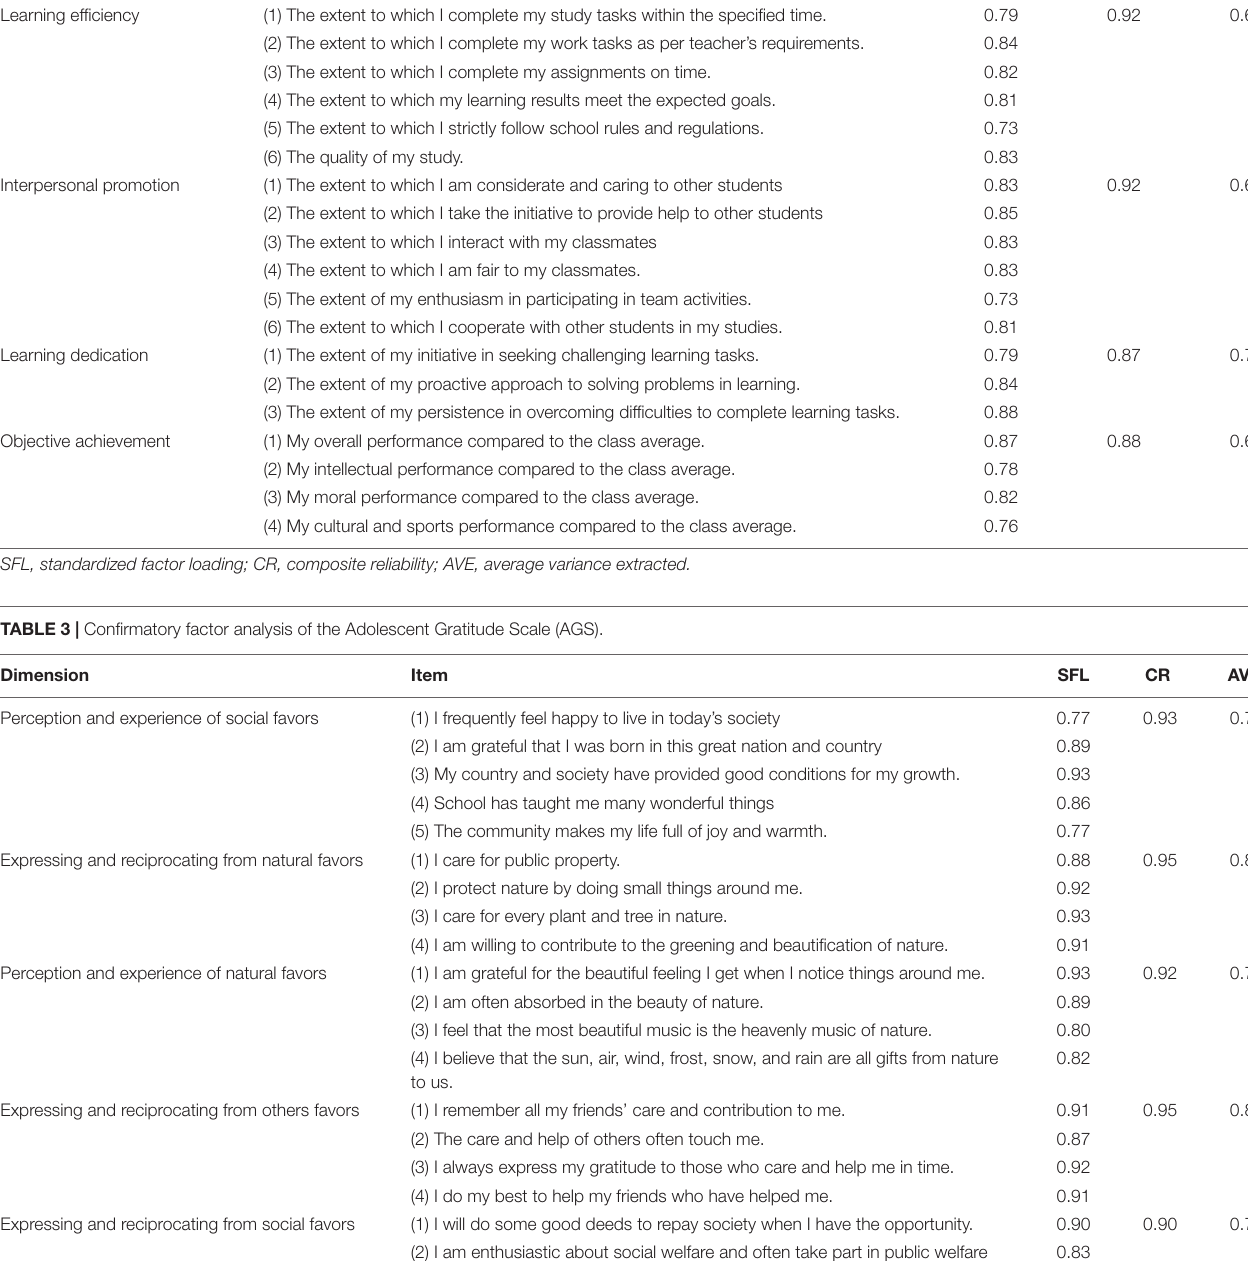
TABLE 2 | Confirmatory factor analysis of the college students’ academic performance scale. Item SFL CR